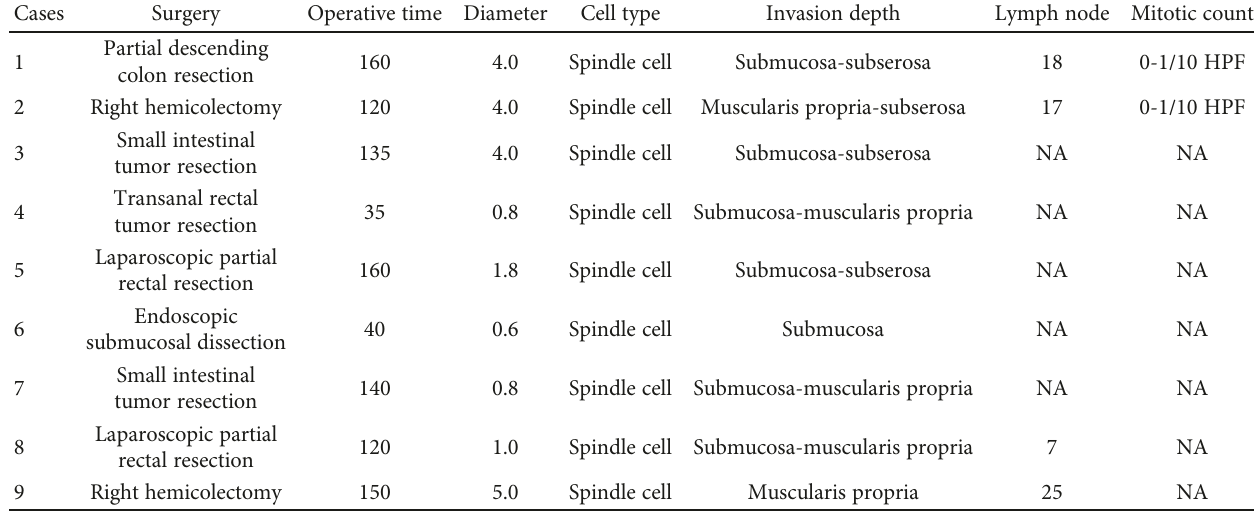
Table 3: Surgical and pathological features of patients with intestinal